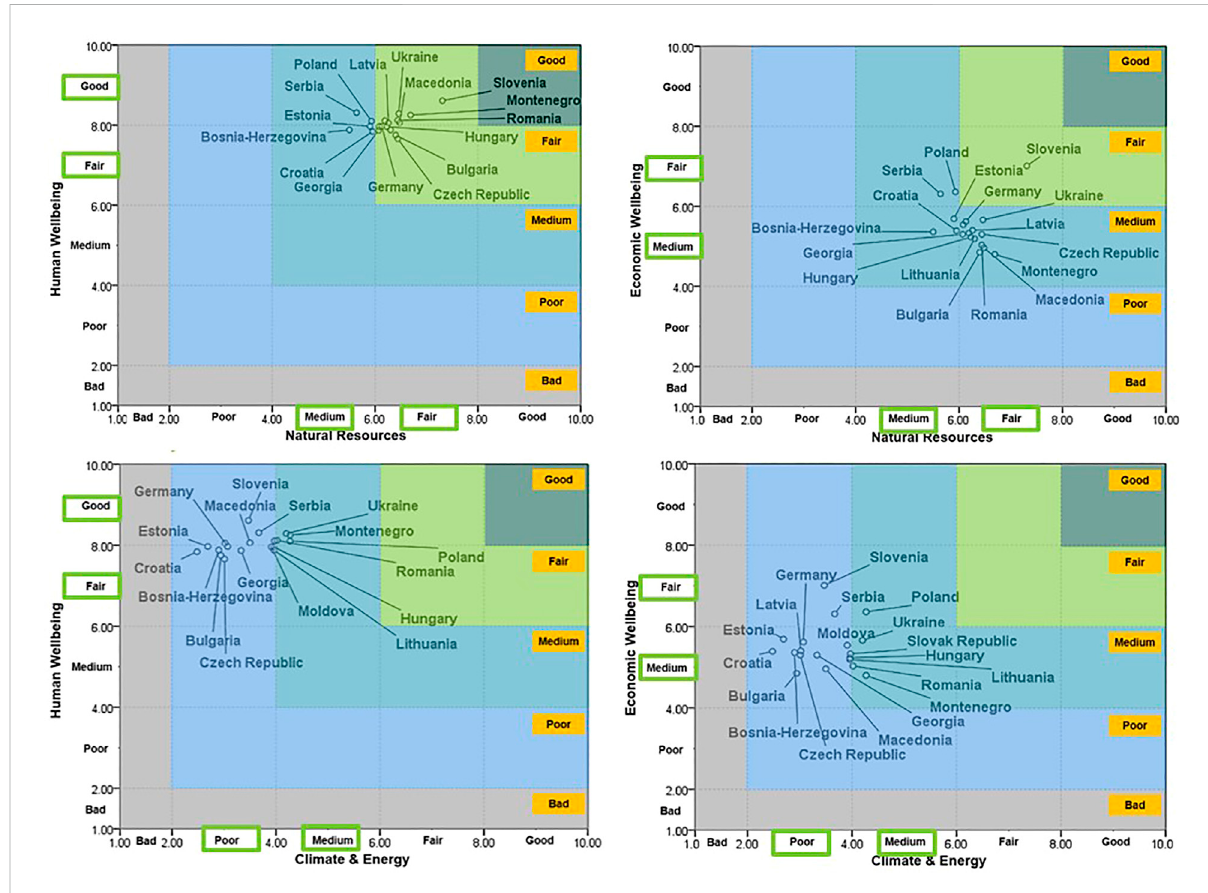
FIGURE 8 Graphic representations of the relationships between human and economic wellbeing and components of environmental